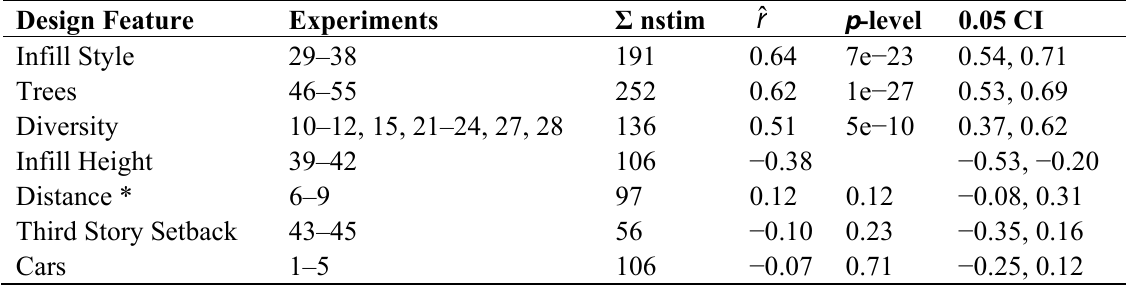
Table 2. Efficacies of design features on street